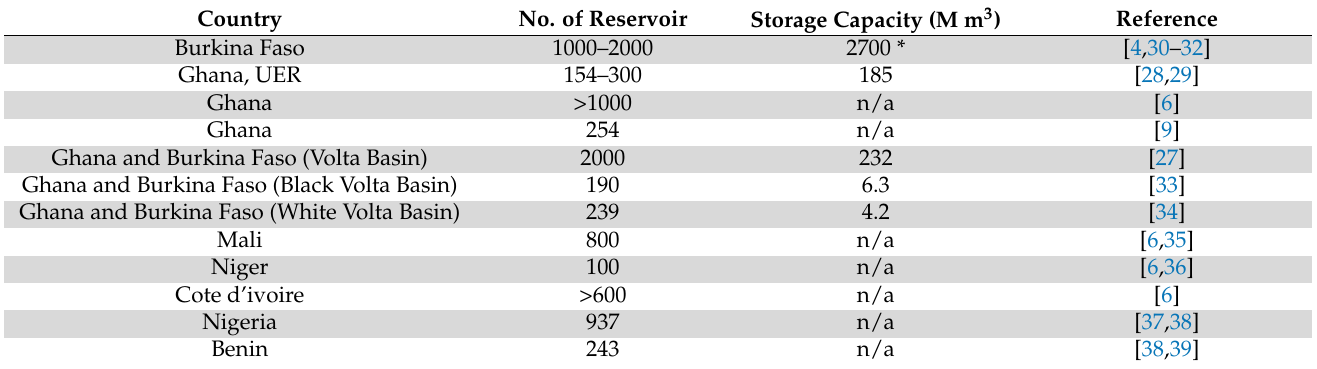
Table 3. Estimated number of small reservoirs and their storage capacity in West